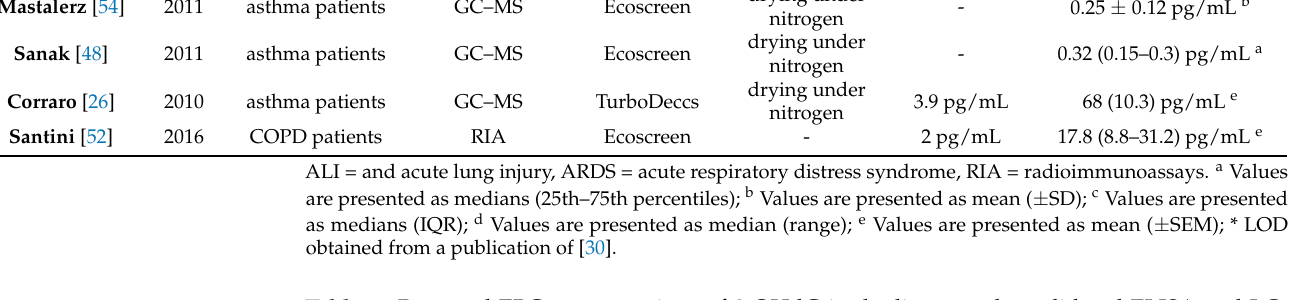
Table 4. Reported EBC concentrations of 8-OHdG in the literature by validated ELISA and LC– MS